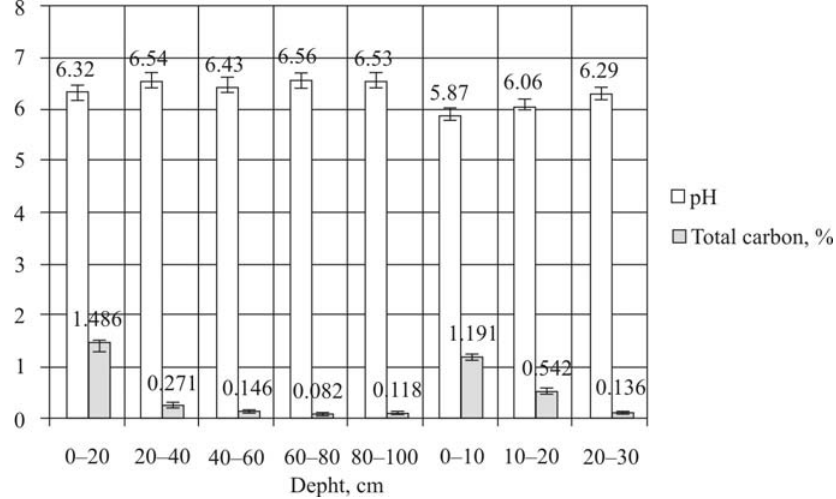
Fig. 5. Soil pH and total carbon content in arable